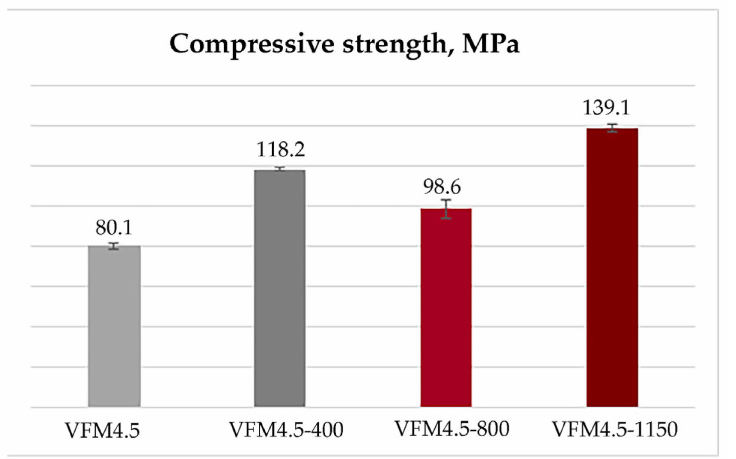
Figure 4. Compressive strength of the initial and thermally treated geopolymers series to 400, 800 and 1150 ◦